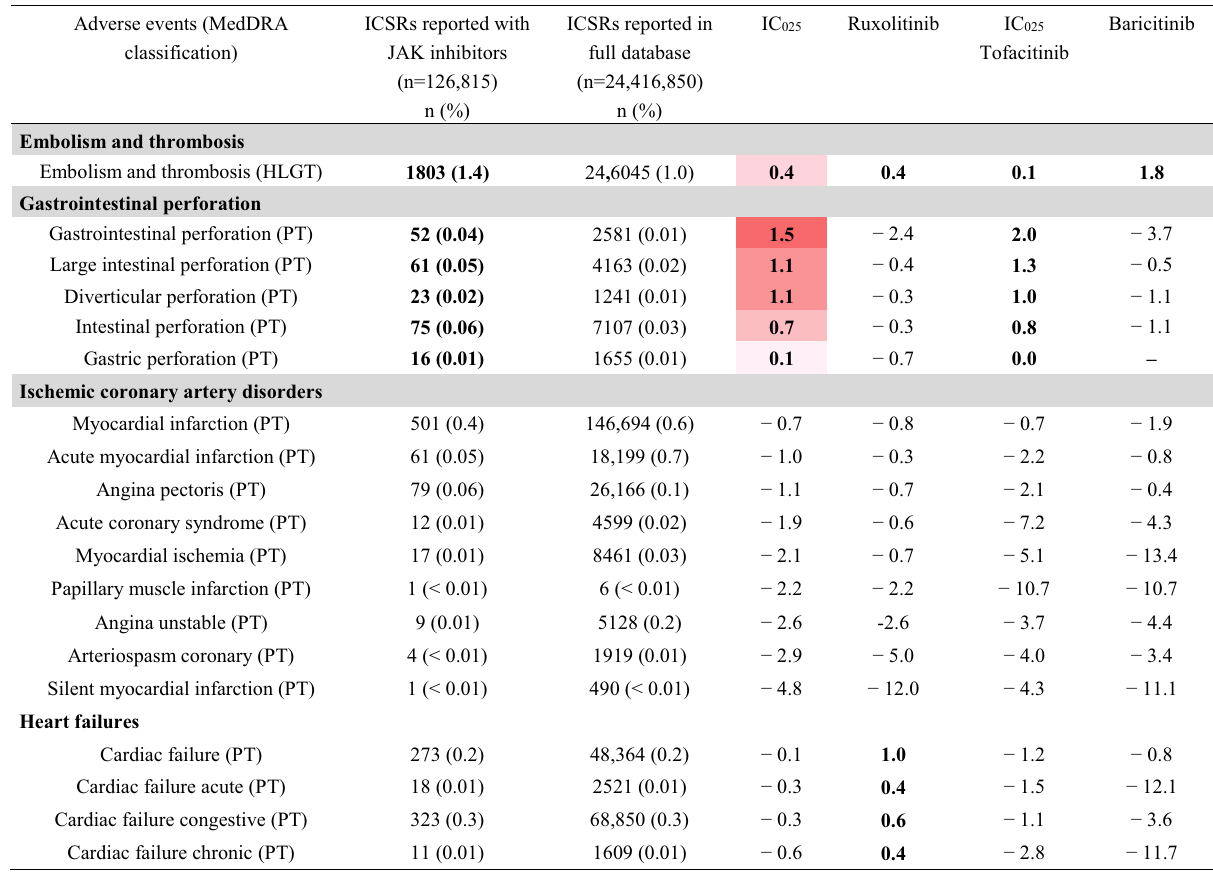
Table 3. Embolism and thromboembolic, gastrointestinal perforation and major cardiovascular adverse events related to JAK inhibitors. Significant values are given in